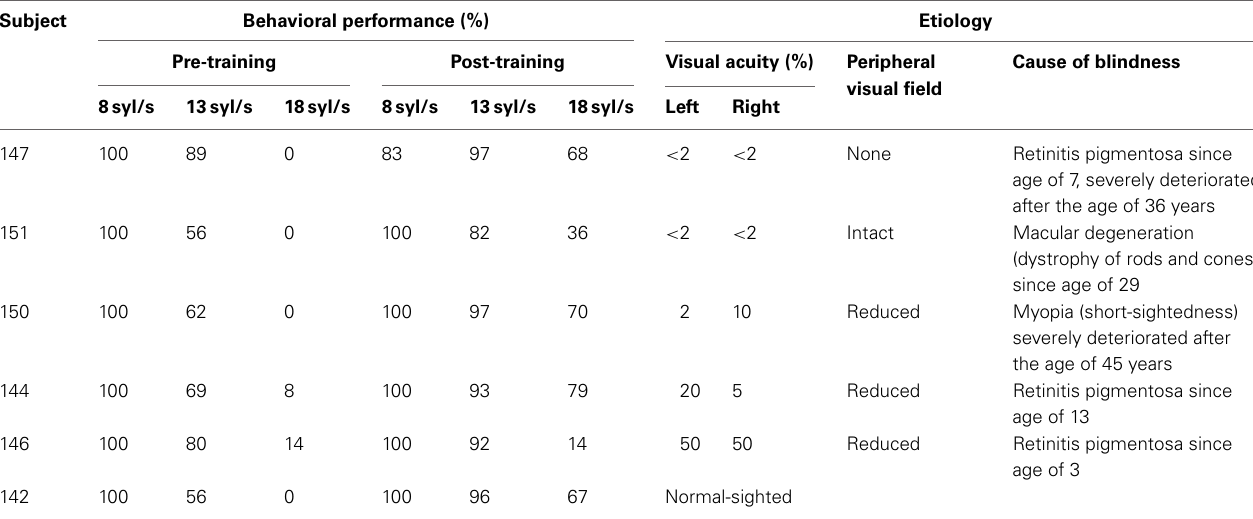
Table 1 | Clinical and behavioral data of the vision-impaired and healthy